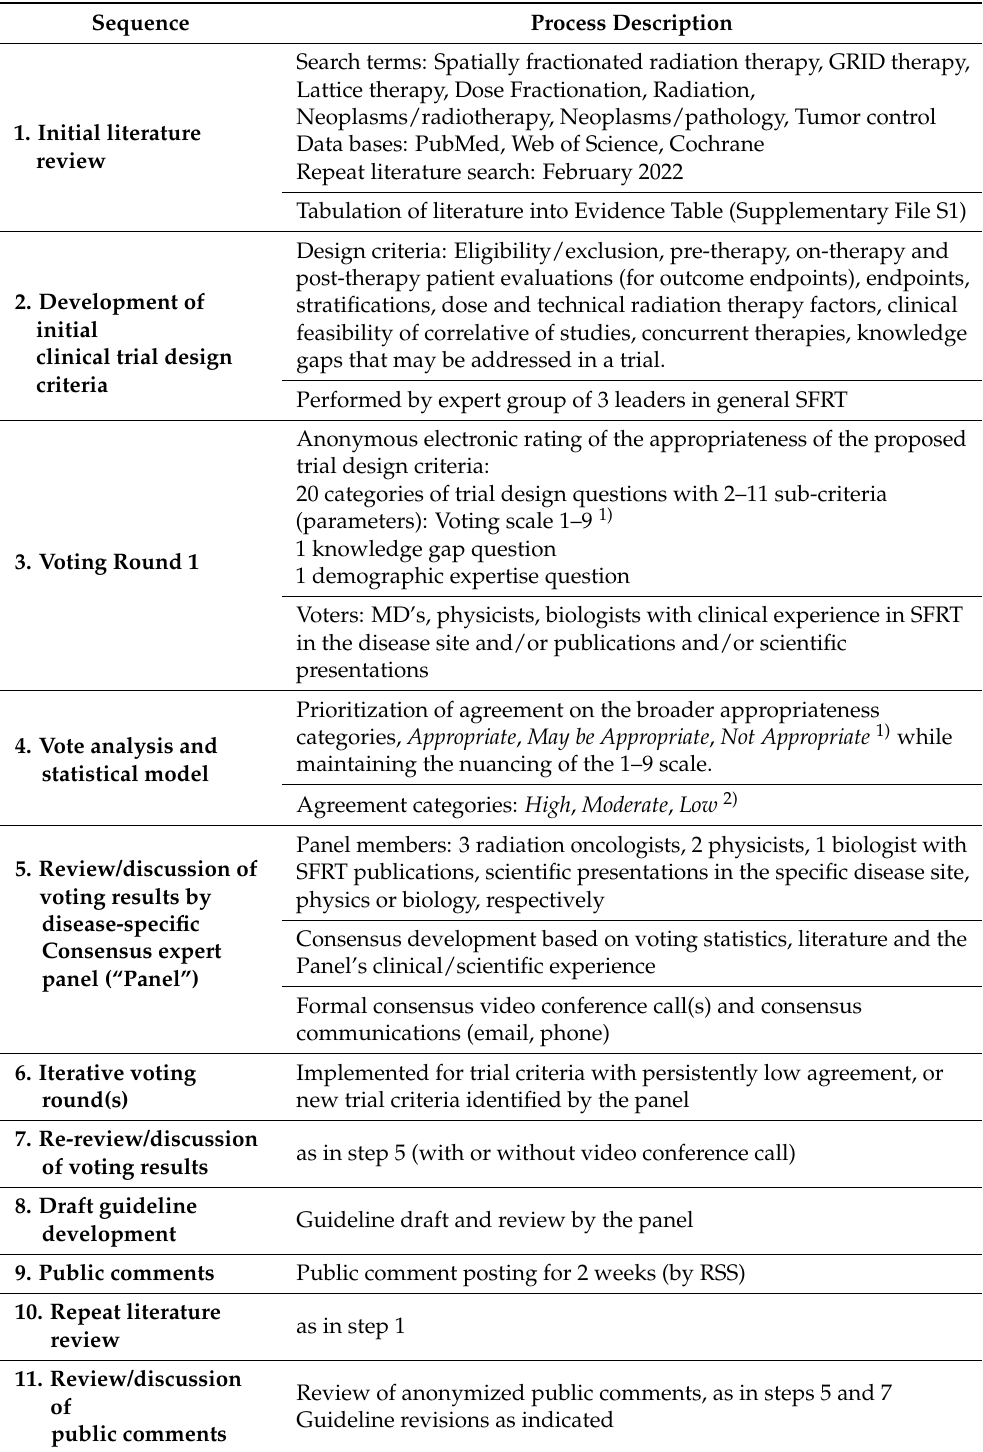
Table 1. Synopsis of Consensus Development Process. Table reprinted with permission from Mayr et al.